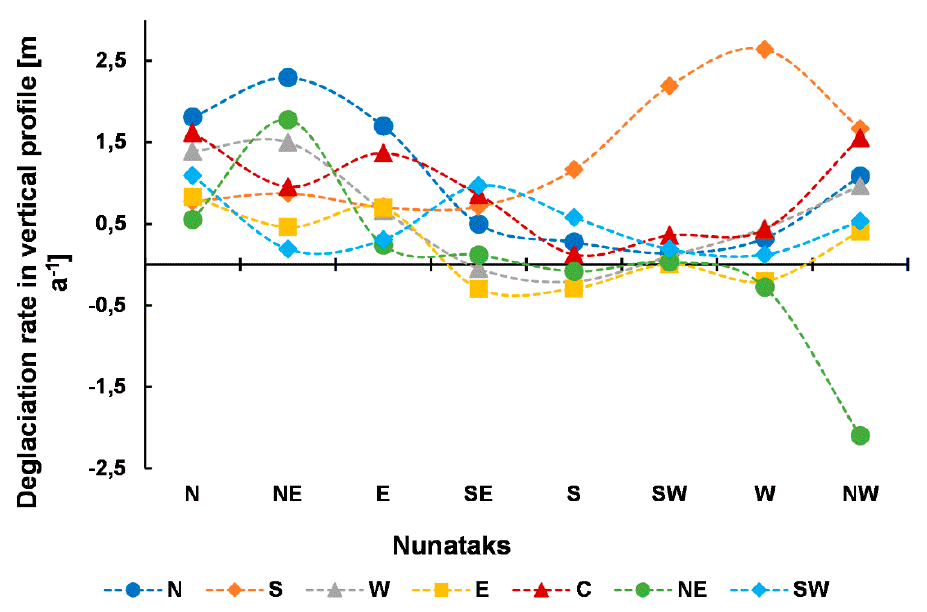
Figure 7. Average rate of change for the mean nunatak elevation on Spitsbergen in relation to slope exposure.